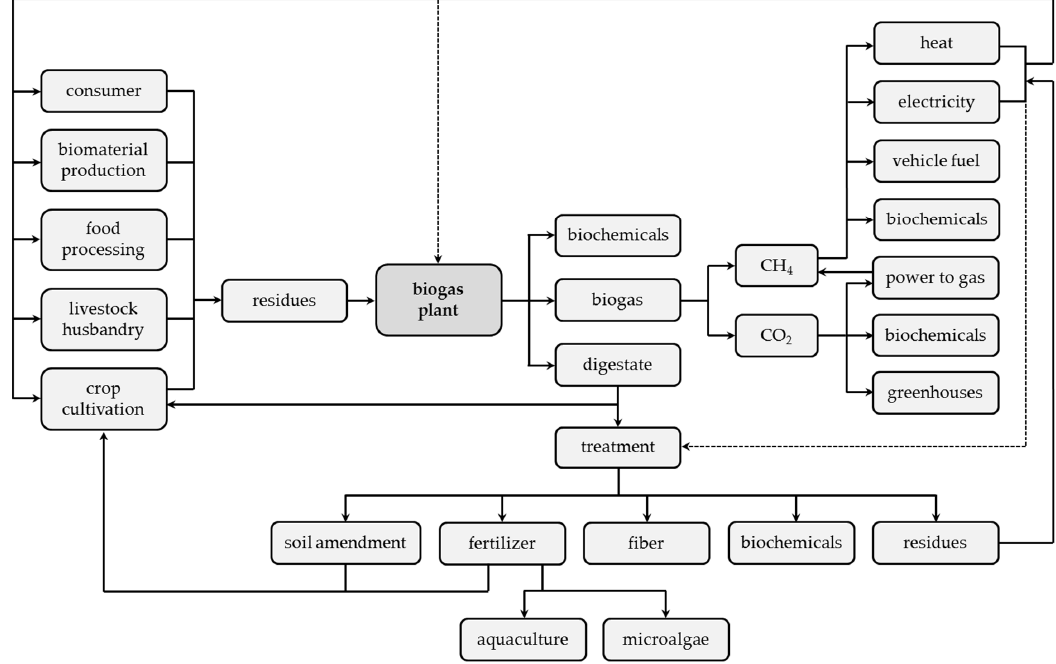
Figure 4. Biogas plant in bioeconomic systems for the integrated production of food, bioenergy and biomaterials (arrows indicate biomass and/or energy flows, dashed arrows indicate in-process energy flows).